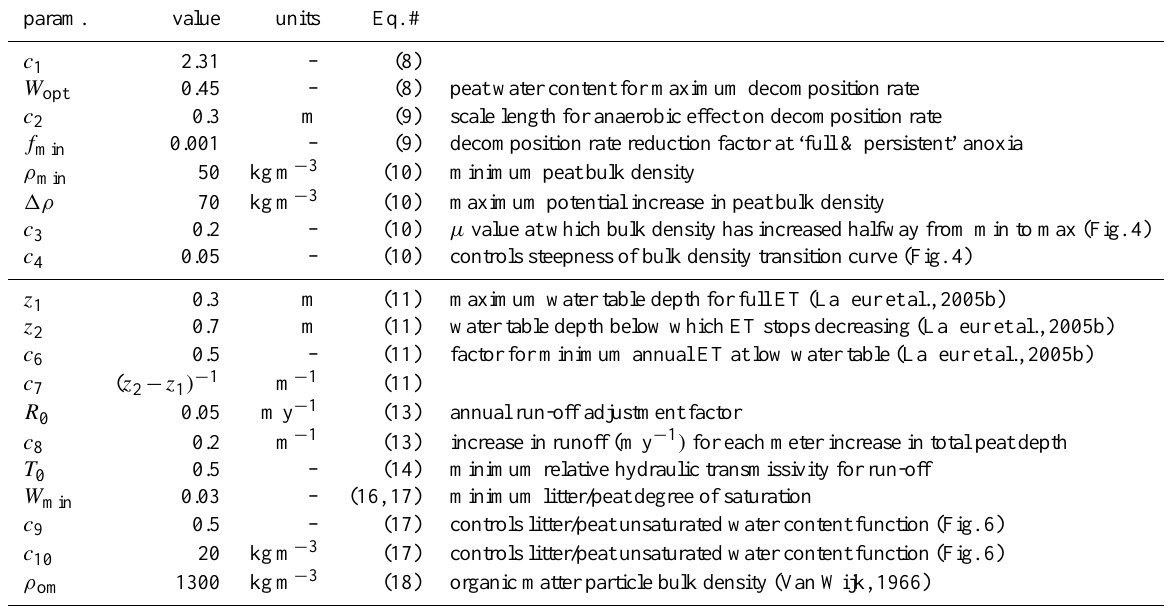
Table 2. Model parameter values for peat properties. param.